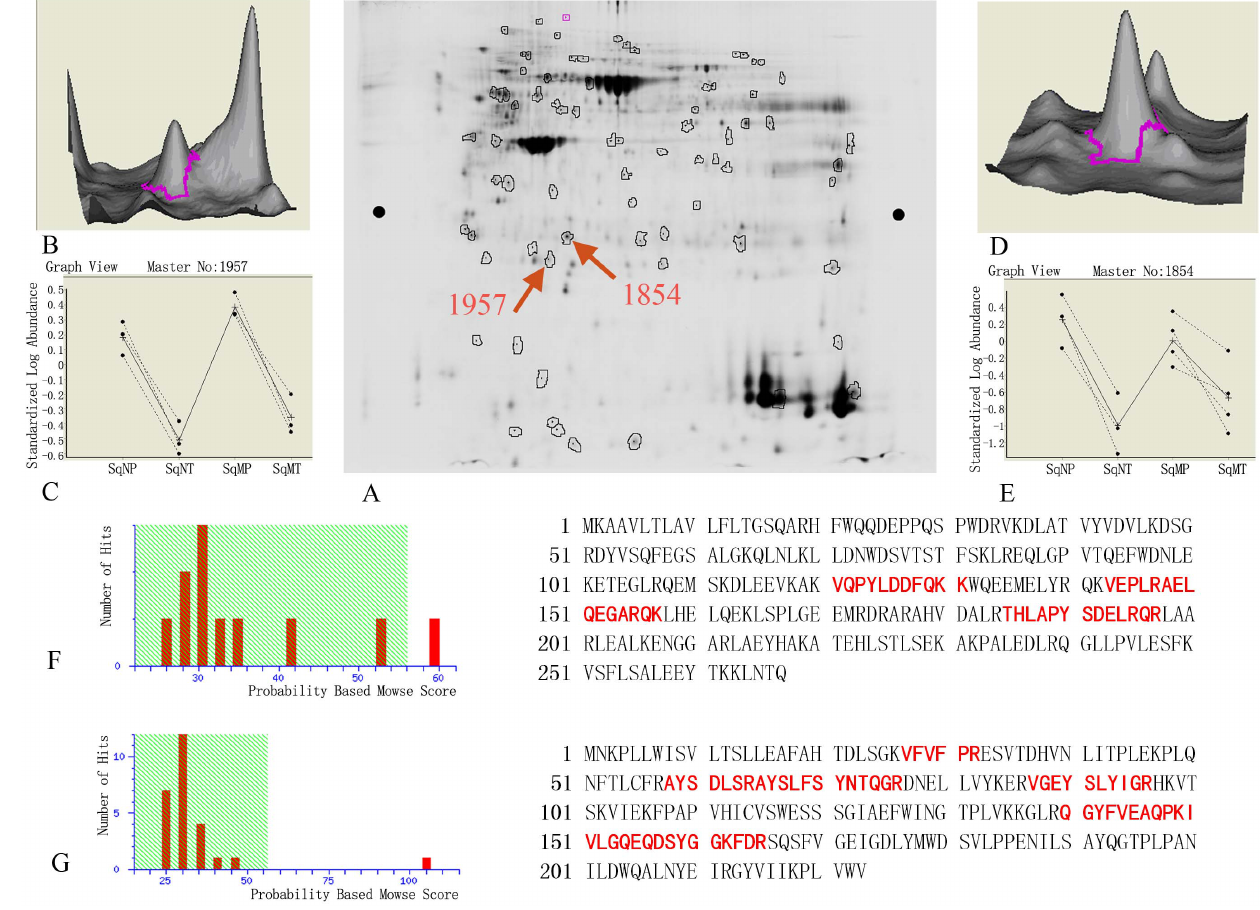
Figure 3. Detailed analyses of apoA1 and SAP by 2D-DIGE gel and MS. (A) 2D-DIGE gel images for apoA1 and SAP were labeled as 1957 and 1854. pI and MW for spot 1957 are 5.0 and 30 KD; pI and MW for spot 1854 are 5.5 and 30 KD. (B) and (D): Protein waves for spots 1957 and 1854 in 3- D view show both are single peaks, which signifies high protein content. (C) Comparison of congruity of spot 1957 in tumor and benign tissues of non-metastasis group (SqN) and metastasis group (SqM) shows similar results. Compared to expression in SqNP, expression in SqNT was down- regulated 4.76-fold, P=0.01; Compared to expression in SqMP, expression in SqMT was down-regulated 5.2-fold, P=0.019. (E) Comparison of congruity of spot 1854 in tumor and benign tissues of non-metastasis group (SqN) and metastasis group (SqM) shows similar results. Compared to expression in SqNP, expression in SqNT was down-regulated 14.55-fold, P=0.0025; comparing to SqMP, expression in SqMT was down-regulated 3.72-fold, P=0.041. (F) The Mascot Score of spot 1957 confirmed by MALDI-TOF-MS was 59. After hydrolysis of apoA1, the matching rate of peptides with the database was 14%. The matched peptides are shown in red (G) The Mascot Score of spot 1957 confirmed by MALDI-TOF-MS was 105. After hydrolysis of SAP, the matching rate of peptides with the database was 27%. The matched peptides are shown in red. stained with Cy5 (red), and from a mixture of all protein samples as the internal standard stained with Cy2 (blue). The black-and- white scanning images of each stained gel were showed at right (Figure 1). The digital images were analyzed using DeCyder software. A total of 323 spots were significantly altered in their abundance (P # 0.05) among all the samples. Compared with the corresponding samples of normal tissue, 204 spots showed a greater abundance and 209 showed a lower abundance in the SCC groups. These protein spots are indicated on the gel images shown in Figure 1.